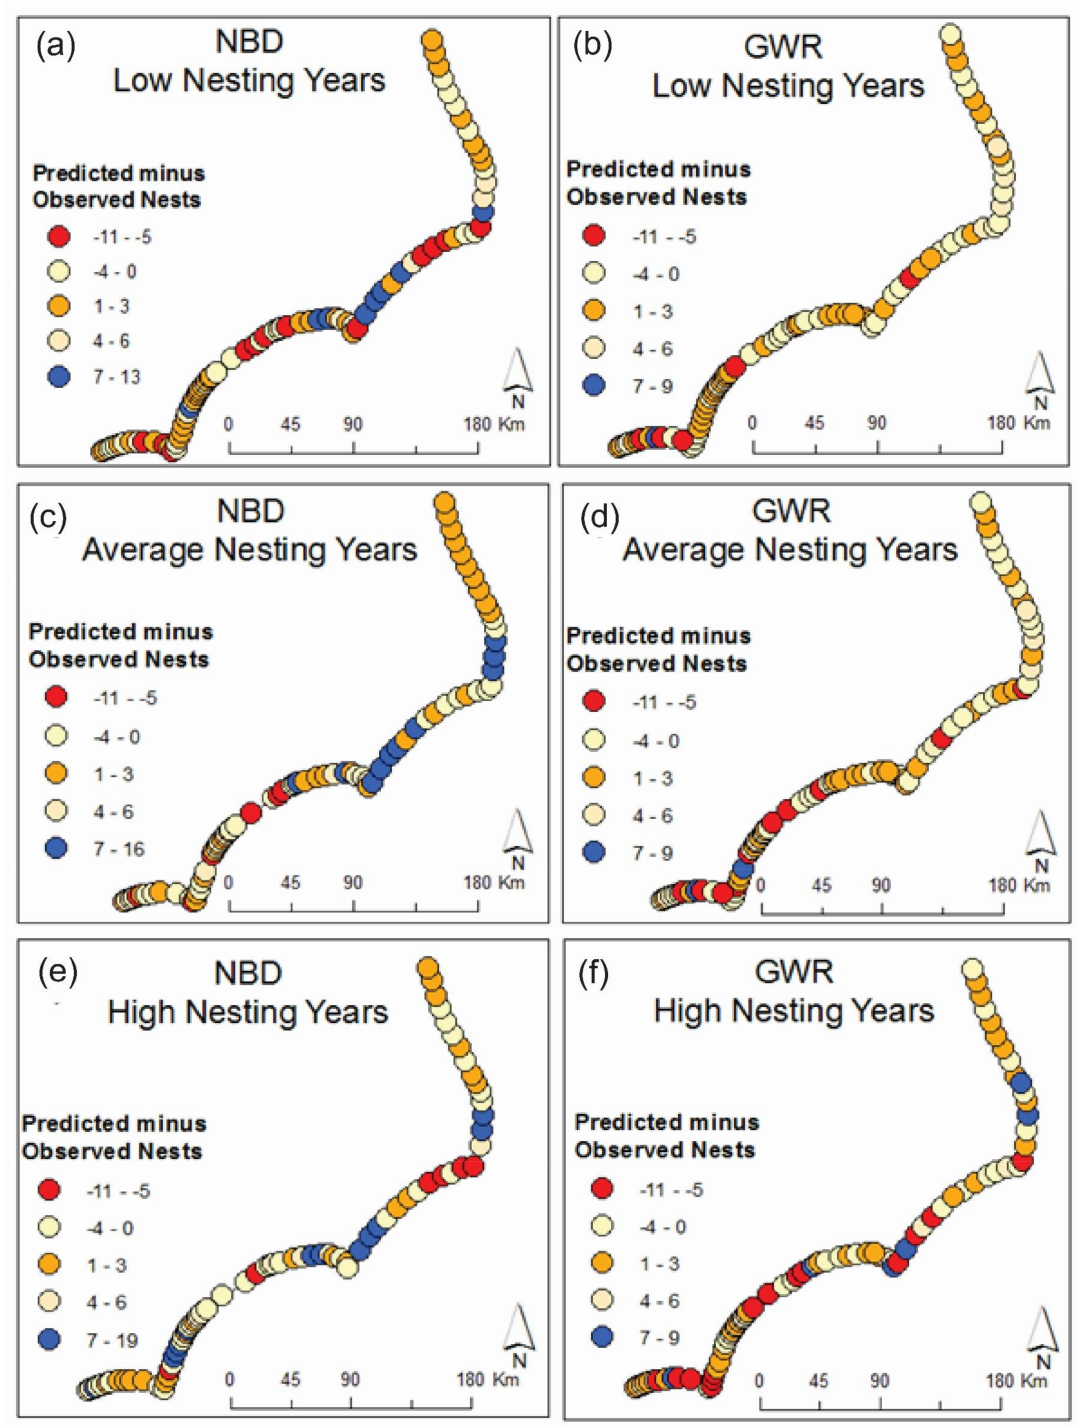
Figure 8. Comparisons of NBD and GWR models for low (2007, 2009, 2014), average (2005, 2006, 2008), and high (2010–2013) nesting years: ( a ) low NBD, ( b ) low GWR, ( c ) average NBD, ( d ) average GWR, ( e ) high NBD and ( f ) high